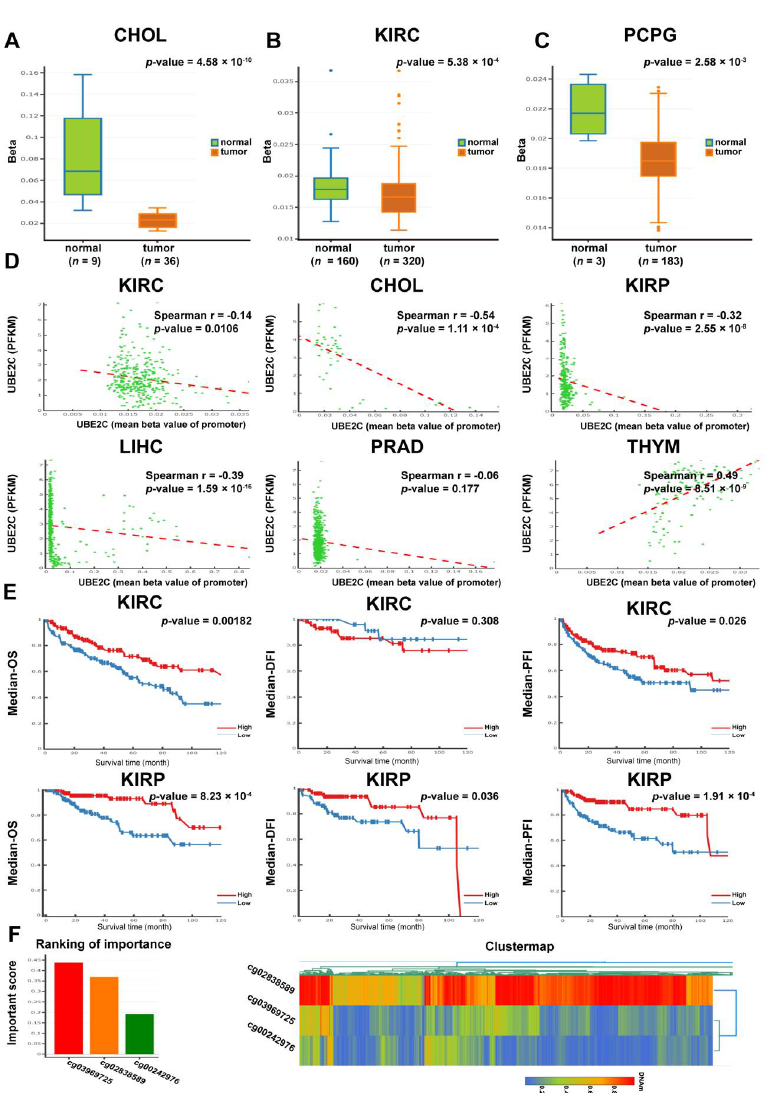
Figure 4. DNA methylation analysis data of UBE2C in pan-cancer. All analyses were performed by the DNMIVD website. ( A – C ). The DNA methylation levels of UBE2C in tumor tissues and normal tissues for CHOL ( A ), KIRC ( B ), and PCPG ( C ) ( p < 0.01). ( D ). Spearman correlation analysis between the expression levels and DNA methylation levels of UBE2C in various cancer types ( p < 0.05). ( E ). The association between the DNA methylation level of UBE2C and clinical prognosis (OS, DFI, and